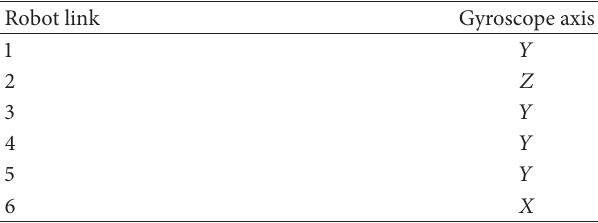
Table 3: Gyroscope axis used for estimating angular